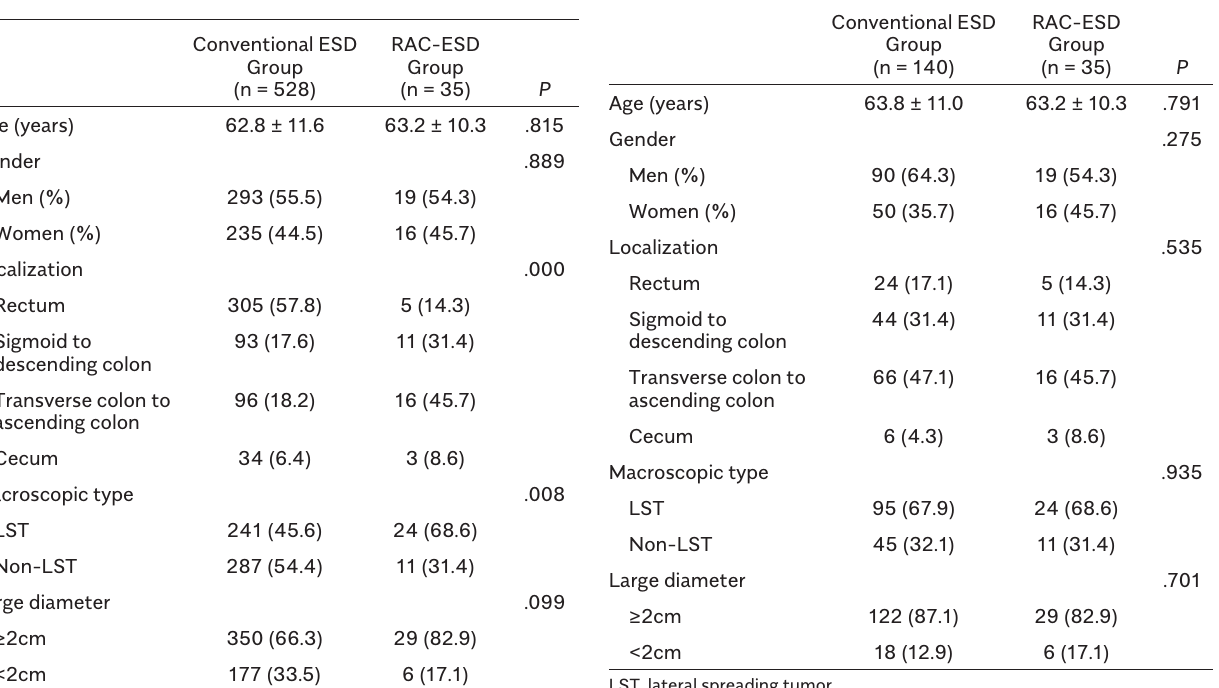
Table 1. Baseline Characteristics of Patients with Superficial Colorectal Neoplasms Treated by Conventional Endoscopic Submucosal Dissection (ESD) and Inner Traction-Facilitated ESD Using Rubber Band and Clip (RAC-ESD) in the Unmatched